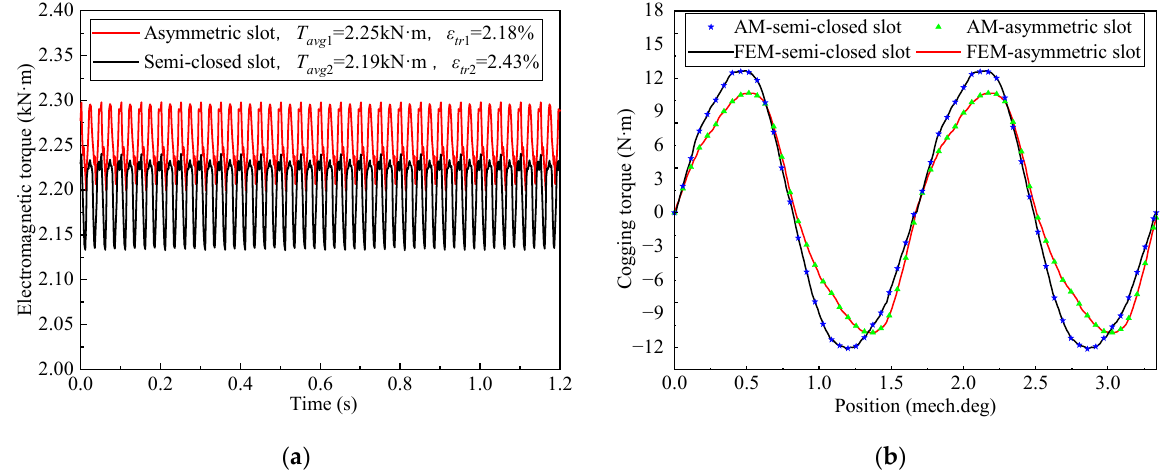
Figure 11. Comparison of electromagnetic characteristics between semi-closed slot model and asymmetric slot model: ( a ) electromagnetic torque; ( b ) cogging torque. Table 3. Comparison of Electromagnetic Characteristics Between Asymmetric Slot Model and Traditional Semi-closed Slot Model.